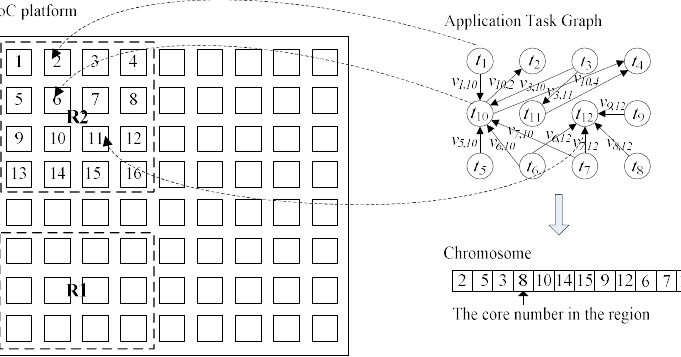
Figure 1. Potential mapping regions for an application with 12 tasks.